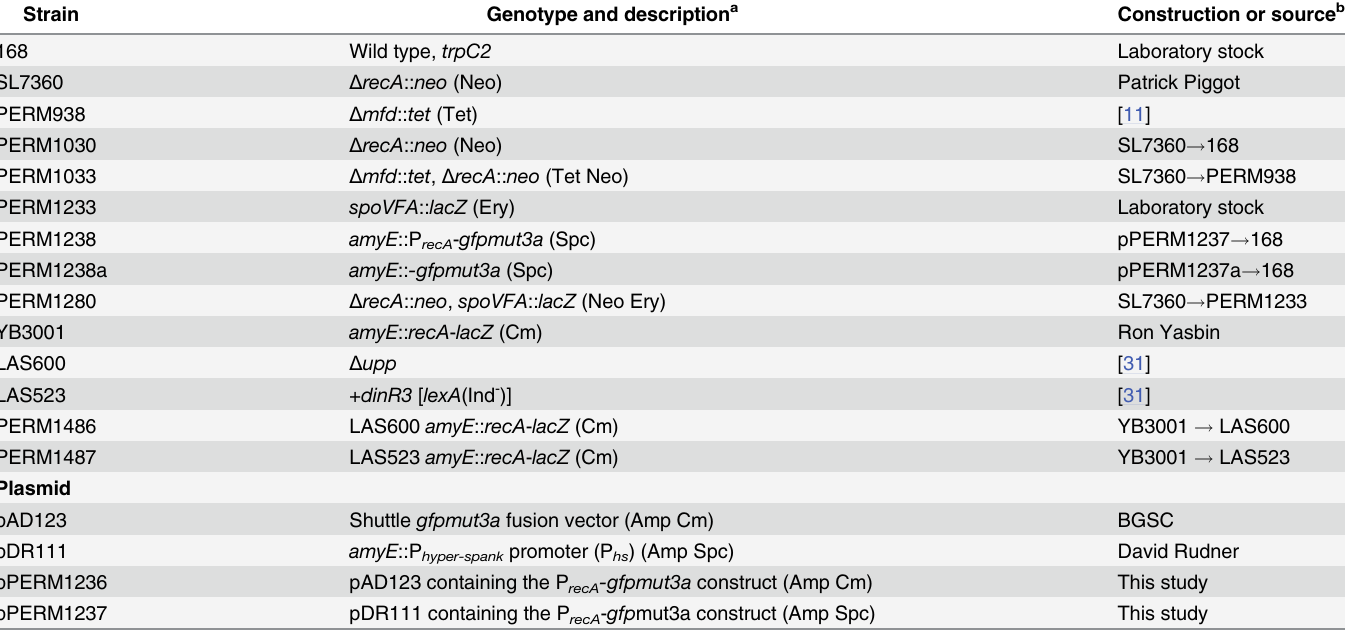
a Selection markers are in parentheses. Antibiotics were used at the following concentrations: Neo, neomycin (12.5 μ g/mL); Tet, tetracycline (10 μ g/mL); Ery, erythromycin (5 μ g/mL); Spc, spectinomycin (100 μ g/mL); Amp, ampicillin (100 μ g/mL) and Cm, chloramphenicol (5 μ g/mL). b “ X ” ! “ Y ” indicates that “ strain Y ” was transformed with DNA from “ source X ” . BGSC, Bacillus Genetic Stock